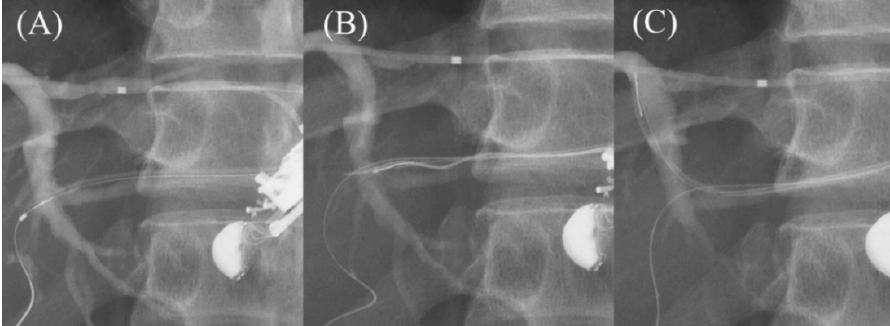
Figure 13. Redirection of a guidewire using a rotatable sphincterotome. In cases where the guidewire cannot be advanced toward hilum even using double guidewire technique ( A ), the guidewire is manipulated with a rotatable sphincterotome by rotating and bending the tip of the catheter while securing the bile duct with another guidewire ( B ). The catheter is successfully advanced toward the hilar region ( C